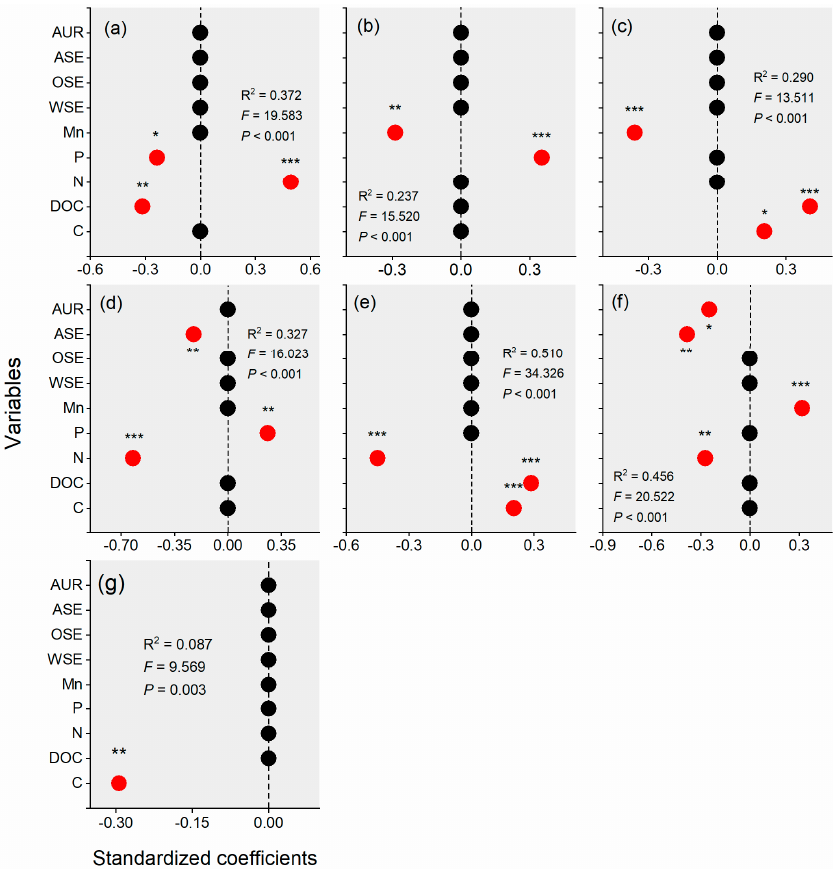
Figure 5. Results of stepwise regression analysis of the functional C groups (( a ): aliphatic C, ( b ): methoxyl C, ( c ): O-alkyl C, ( d ): di-O-alkyl C, ( e ): aromatic C, ( f ): phenolic C, and ( g ): carboxyl (C)) using the litter quality (C: carbon; DOC: dissolved organic carbon; N: nitrogen; P: phosphorus; Mn: manganese; WSE: water-soluble extractives; OSE: organic-soluble extractives; ASE: acid-soluble extractives; AUR: acid-unhydrolyzable residues). The dominant variables are emphasized in red in the regression model. The values represent standardized coefficients, and the * indicates significant effects of the variables on the functional C fractions in a given regression model * p < 0.05, ** p < 0.01, and *** p < 0.001. For example, aliphatic C was significantly impacted by P ( p < 0.05), DOC ( p < 0.01) and N ( p < 0.001) in the stepwise regression testing the effects of litter chemical quality on aliphatic C ( a ).